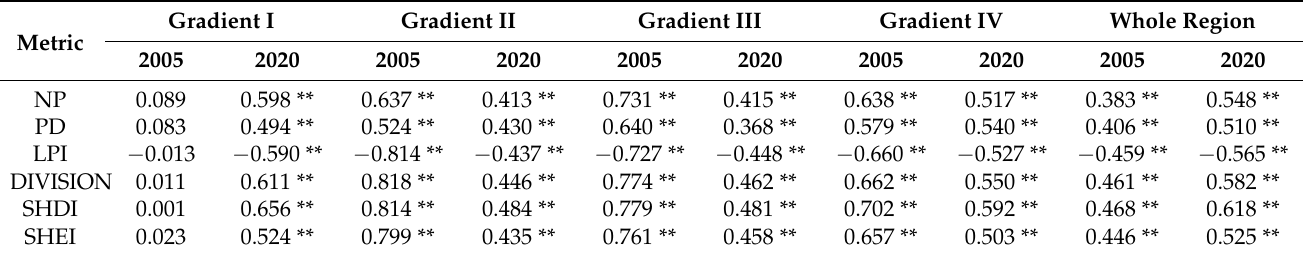
Table 8. Correlation coefficients between habitat quality and landscape metrics in 2005 and 2020.